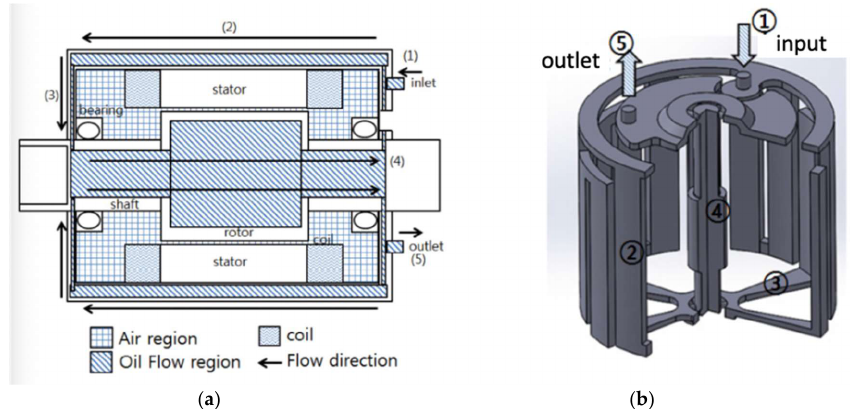
Figure 19. Configuration of an axial flux permanent magnet machine with a centrifugal fan attached on the rotor [46]. Figure 20. Hollow shaft rotor cooling [47]. ( a ) 2D coolant path; ( b ) 3D diagram.